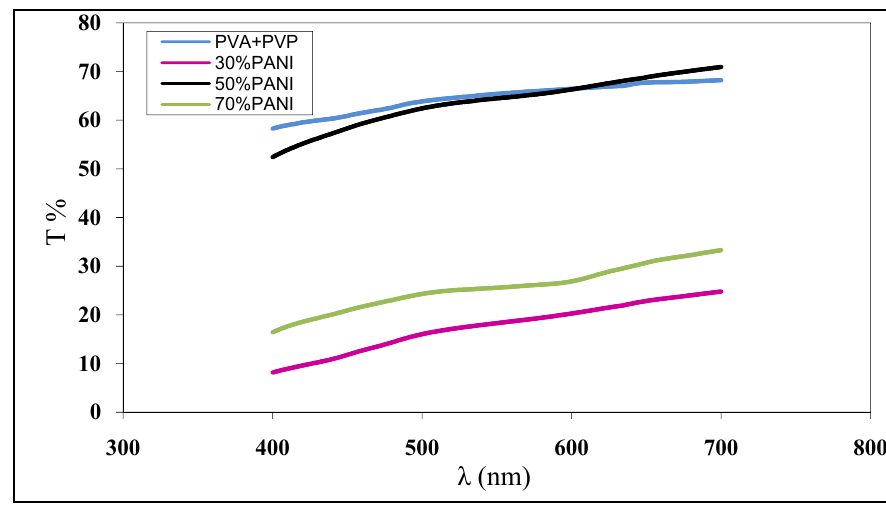
Fig. 2: The transmittance vs. wave length for (PVA-PVP) pure and additive PNAI blends